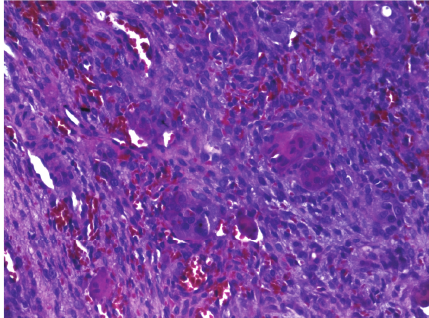
Figure 3: Photomicrograph revealing fragments of dense connec- tive tissue, showing proliferation of ovoid and spindle-shaped cells, multinucleated giant cells, and congested blood vessels (haema- toxylin and eosin stain, original magnification × 200).